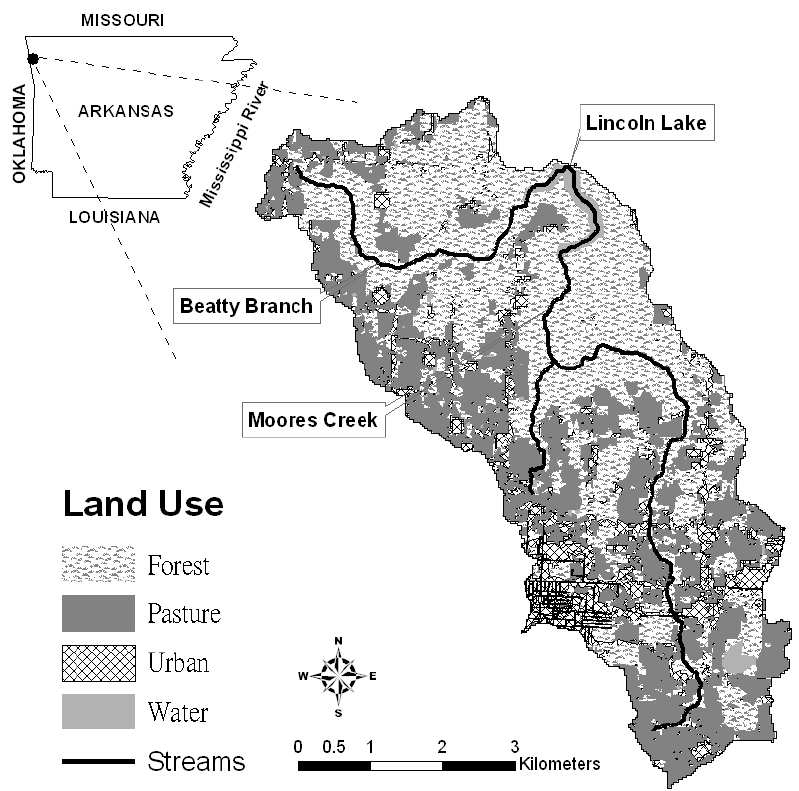
Figure 1. Location of Beatty Branch, Moores Creek, land-use distribution and the gauging stations in the Lincoln Lake